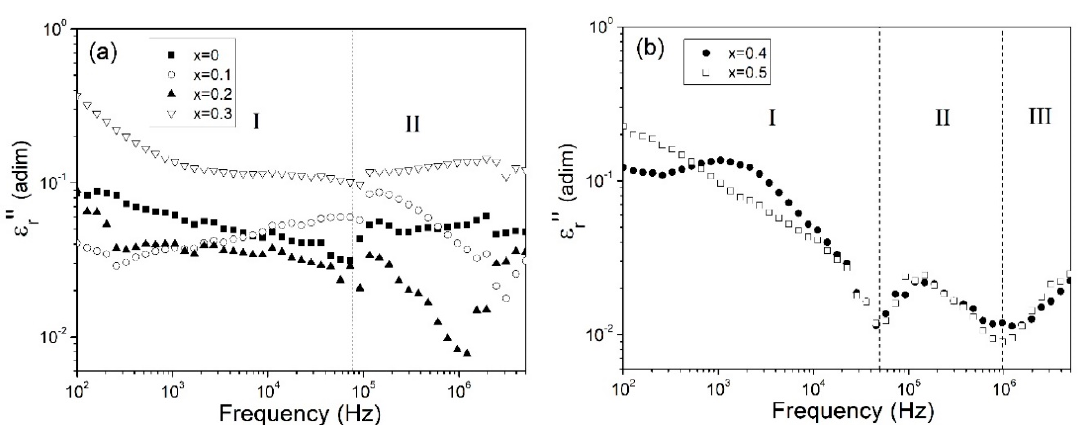
Figure 6. The imaginary part of the complex relative permittivity ( ε ”) at room temperature as function of frequency of Y 1-x Bi x FeO 3 in the range of ( a ) 0 ≤ x ≤ 0.3 and ( b ) 0.4 ≤ x ≤ 0.5, of pressed and sintered samples at 700 °C.